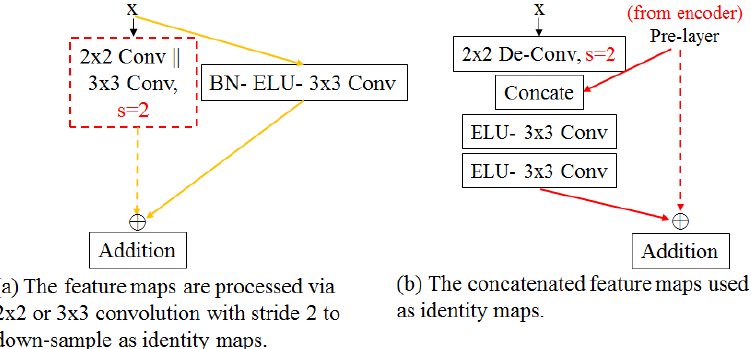
Figure 14. ( a ) Two other different versions of RDU were proposed by us. ( b ) Another version of RUU were proposed by us. Table 6. Comparison between different versions of RDU and RUU. Method IoU (%)